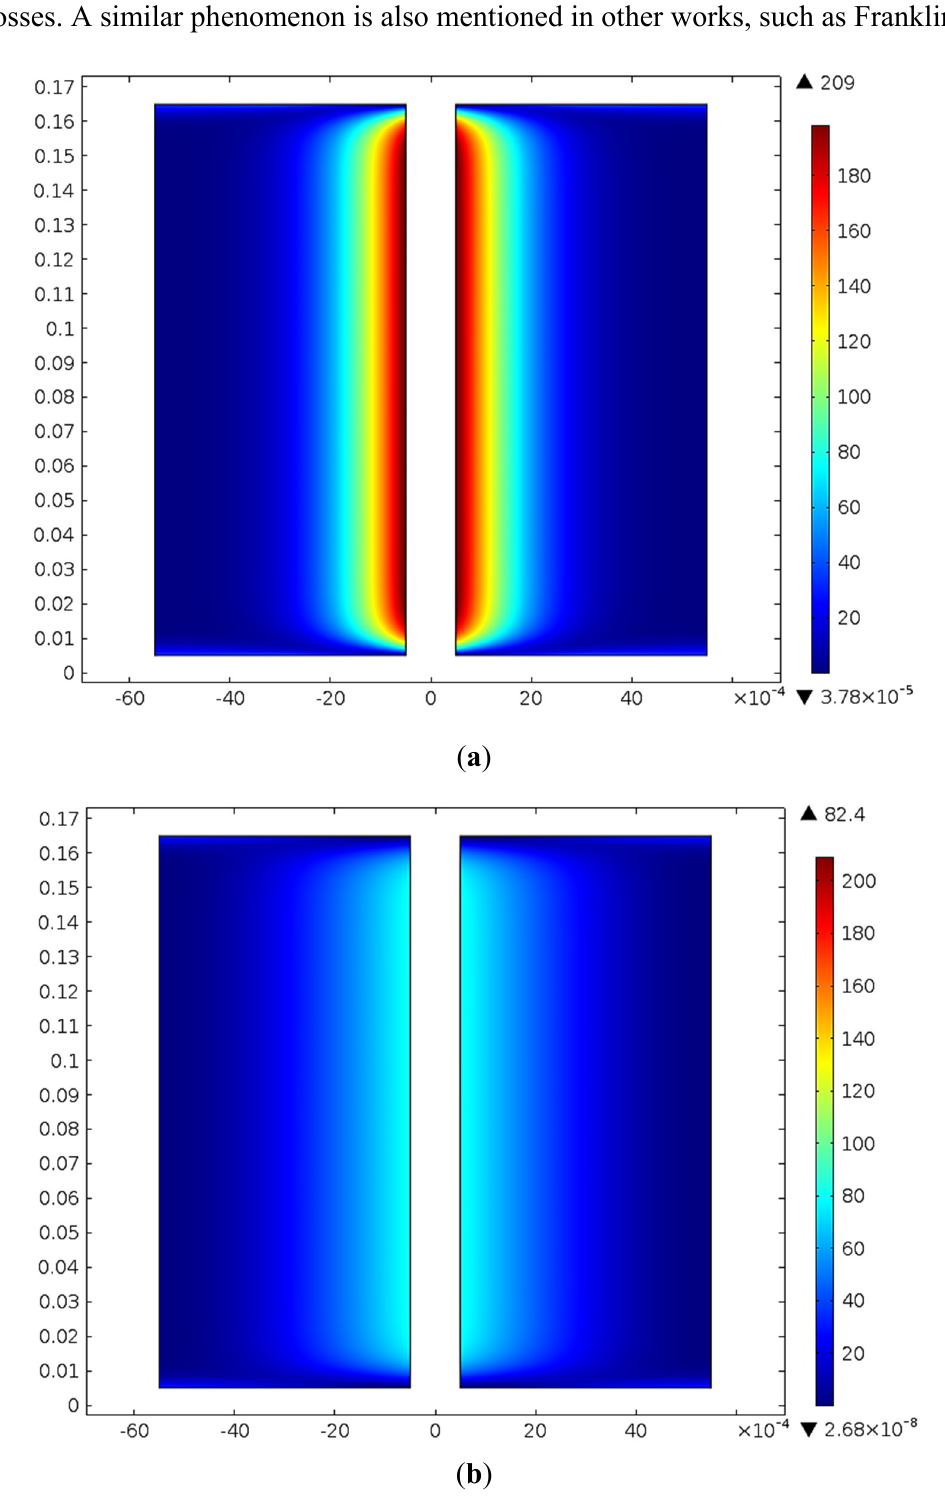
Figure 9. PV cell surface resistive losses distribution under the short circuit condition for: ( a ) Profile 3 ( b ) uniform illumination distribution, x-axis is the bus-bar direction (m) and y-axis is the finger direction